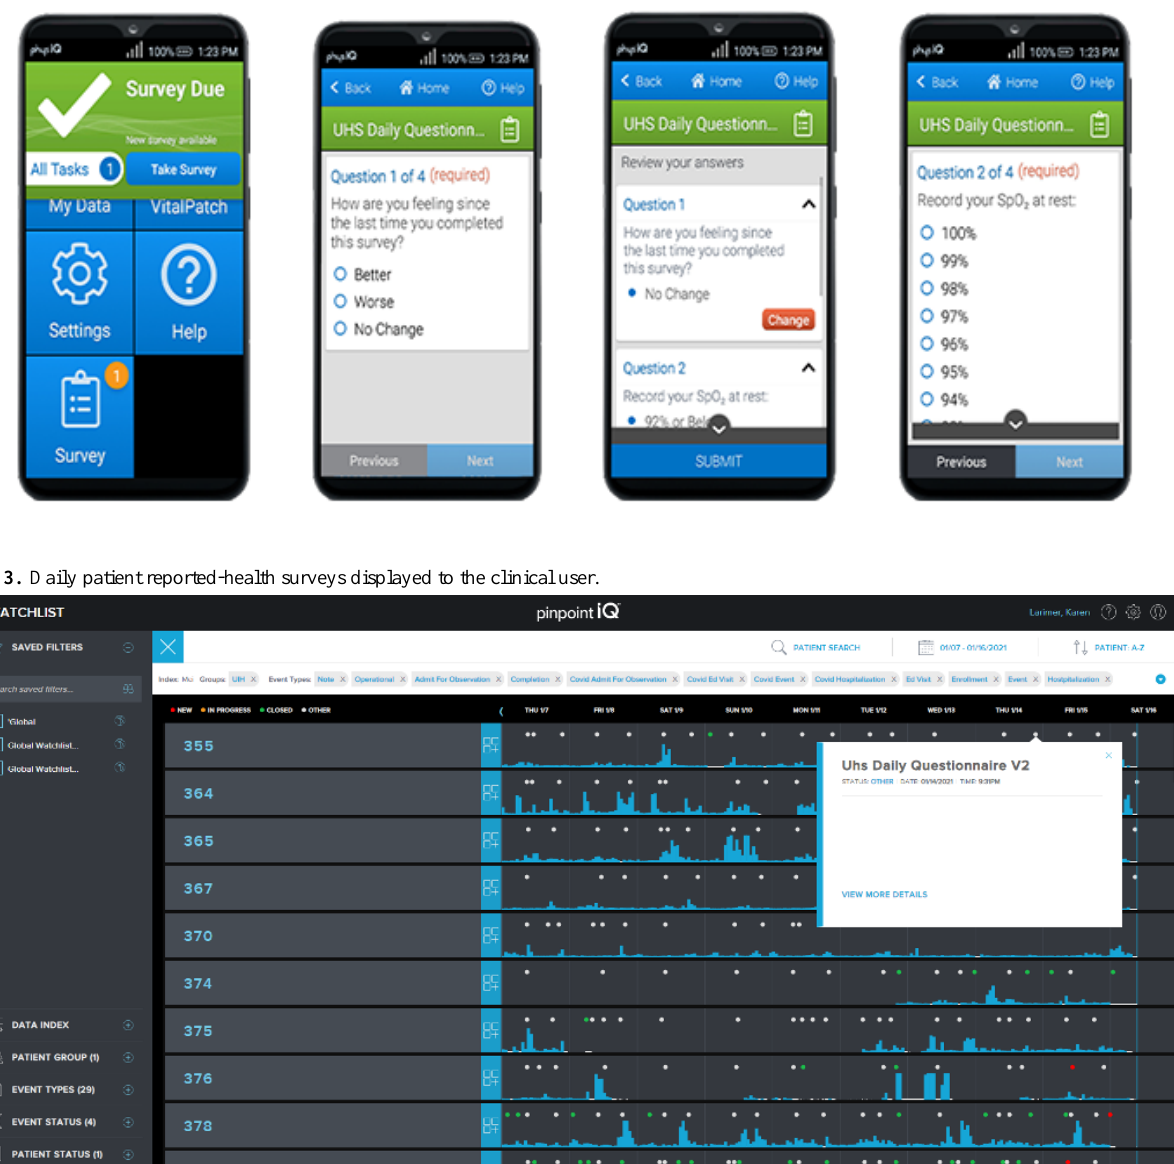
Figure 2. Smartphone app and an example survey.